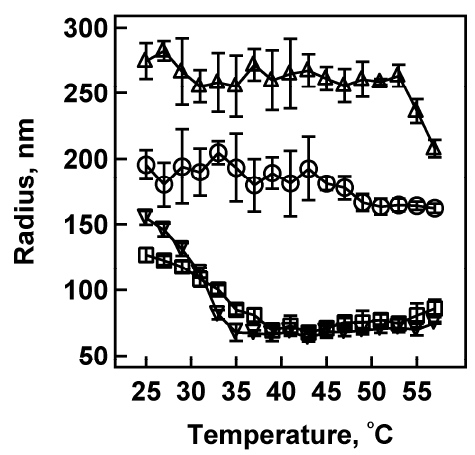
Figure 5. Volume phase transition curves for 2% BIS, 10% AAc nanogels at pH 6.5 ( (cid:52) ), pH 3.0 ( (cid:53) ),